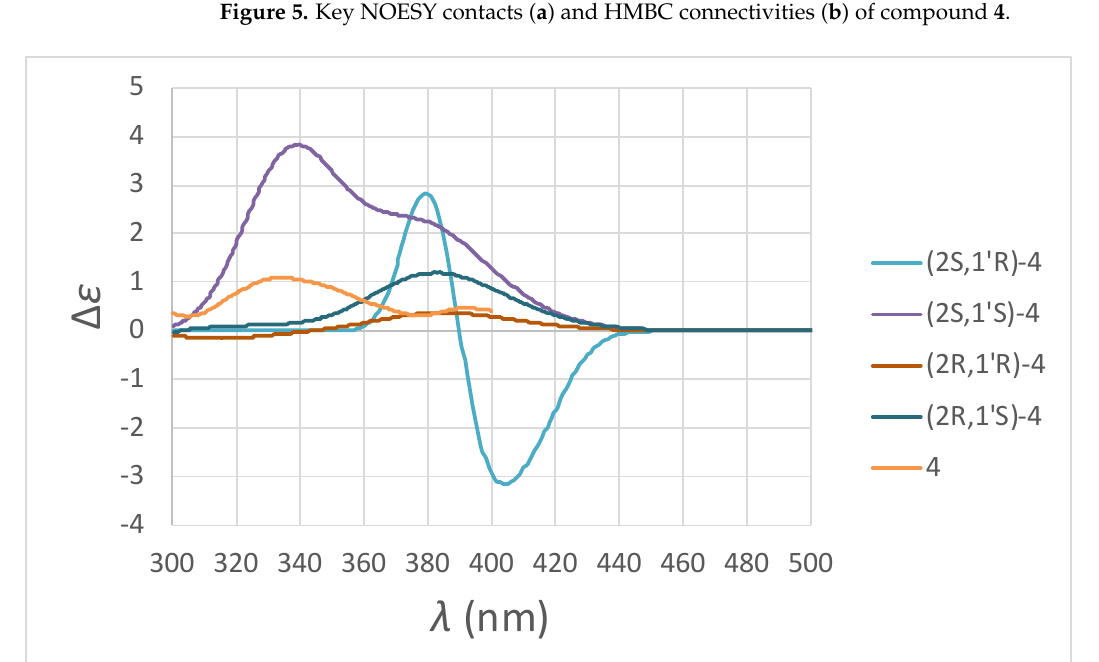
Figure 6. Experimental and calculated ECD spectra of compound 4 .